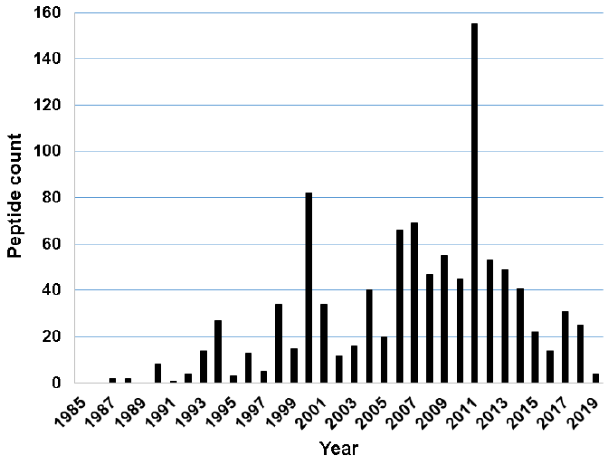
Figure 1. Frog antimicrobial peptides discovered annually from 1985 to 2019. Data in all the figures presented in this study were obtained from the Antimicrobial Peptide Database (http://aps.unmc.edu/AP) in June 2020.